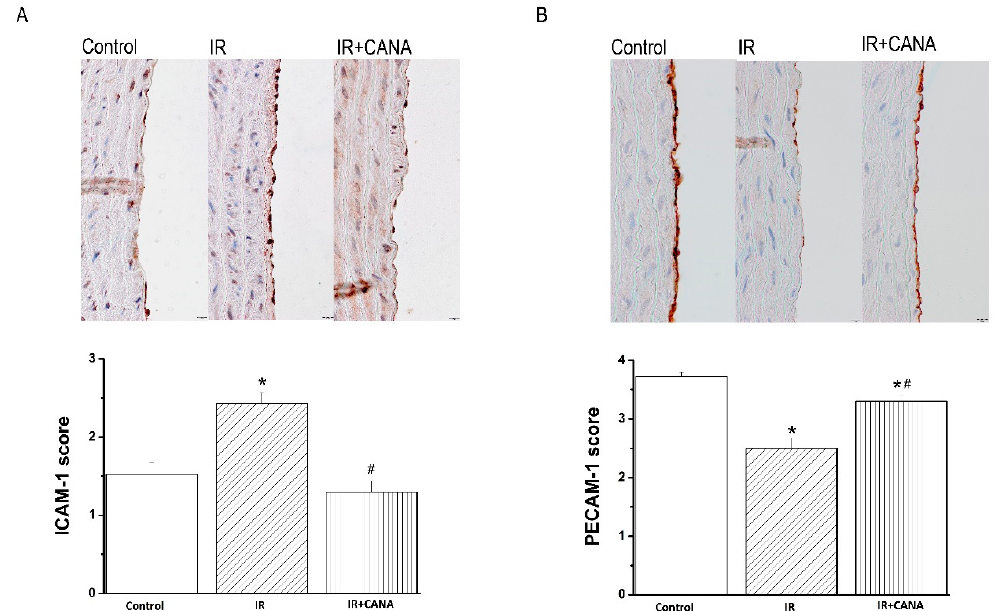
Figure 4. Effect of canagliflozin (CANA) on aortic intercellular adhesion molecule (ICAM)-1 and platelet endothelial cell adhesion molecule (PECAM)-1/CD31 expression after vascular ischemia/reperfusion (IR) injury. Semiquantitative scoring of ( A ) ICAM-1 and ( B ) PECAM-1 immunohistochemical staining with representative micrographs (×400, scale: 10 µm). Results are represented as mean ± SEM. * p < 0.05 versus Control; # p < 0.05 versus IR. n = 28–40 aortic rings from 7–10 rats.